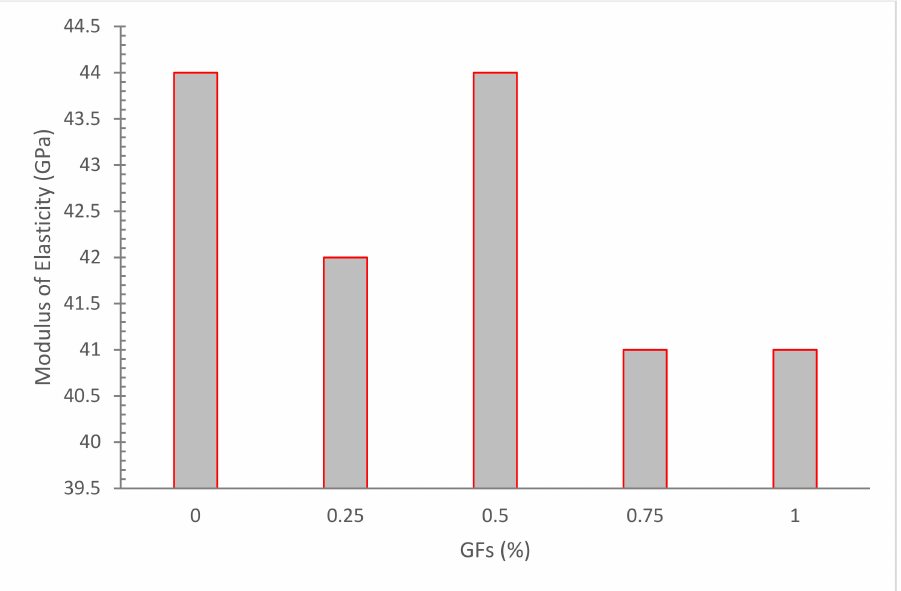
Figure 9. Elastic Modulus: Data Source